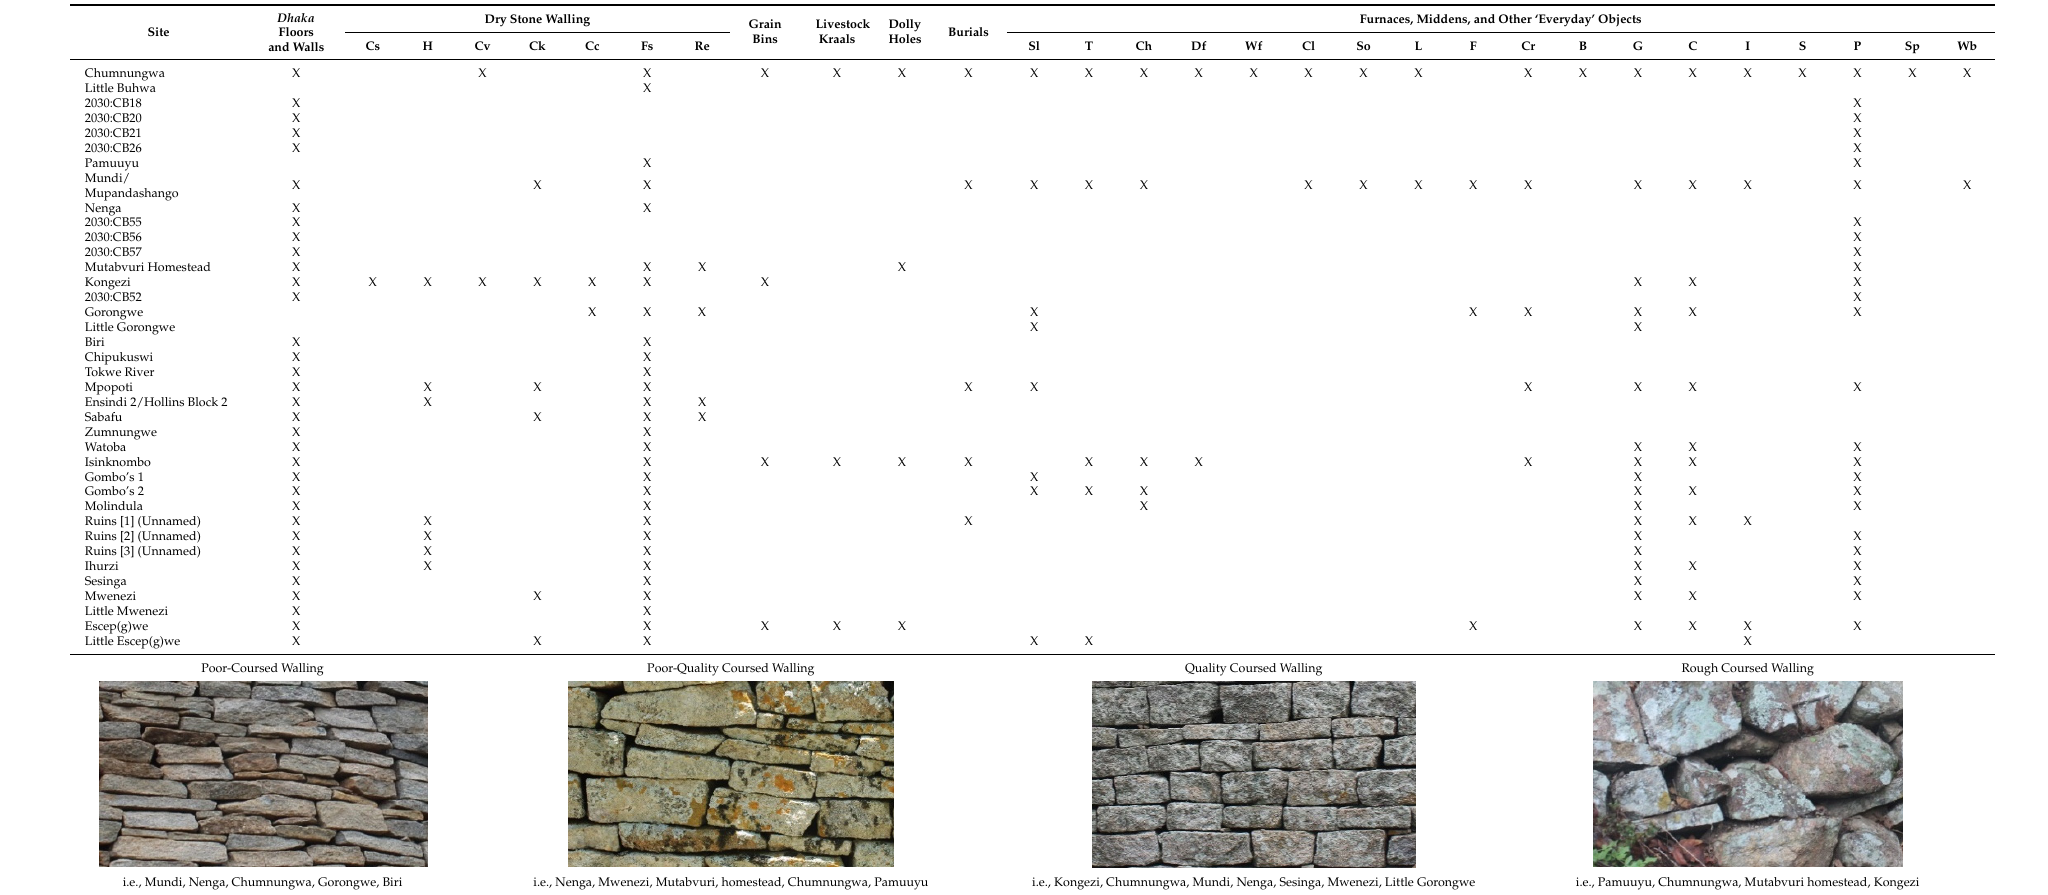
Table 1. Inventory of archaeological finds that were recorded at Zimbabwe tradition sites in